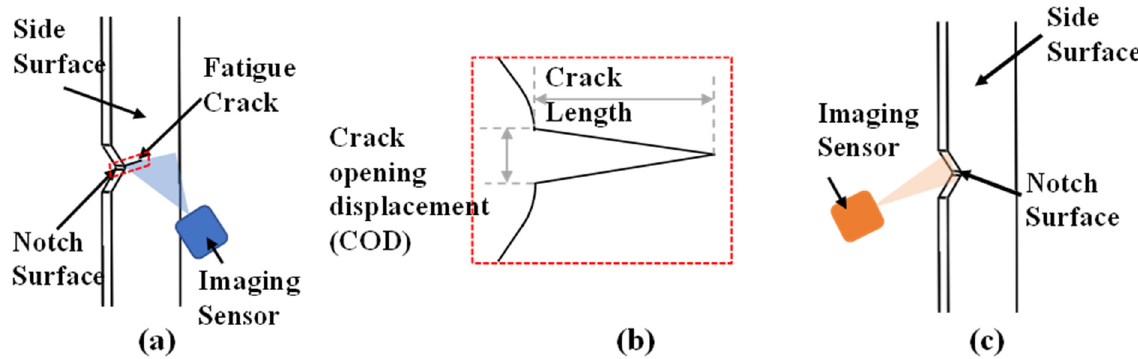
Figure 1. ( a ) Schematic of a representative fatigue specimen with a one-sided V-notch illustrating the view area of the imaging sensors for fatigue crack detection; ( b ) Characterization of the crack length and the crack opening displacement (COD) used in the current work; ( c ) A potential alternative orientation of an imaging sensor to observe COD.